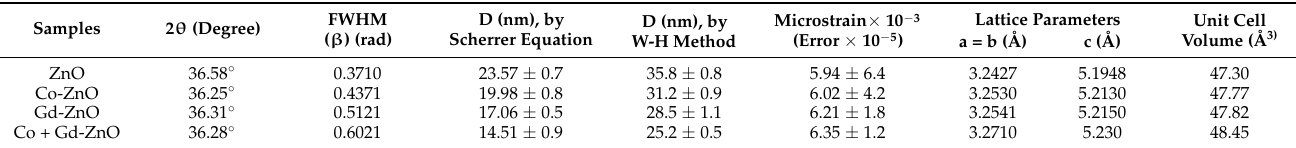
Table 1. Peak position, crystallite size, FWHM, and volume of the unit cell of the samples. Samples